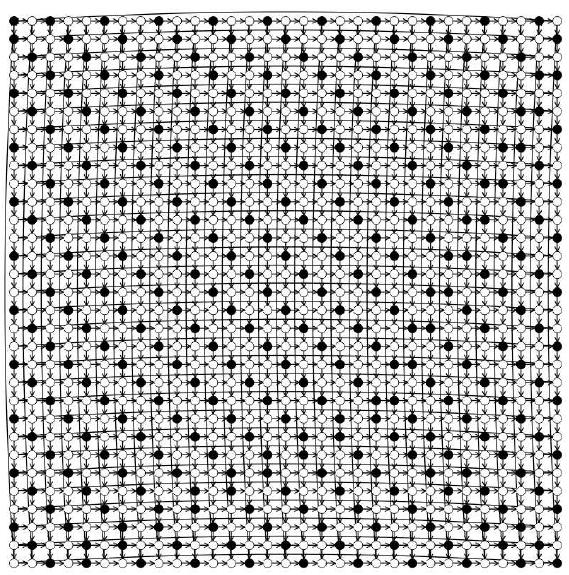
Figure 3. A dominating set with 331 vertices in C 31 (cid:3) C 31